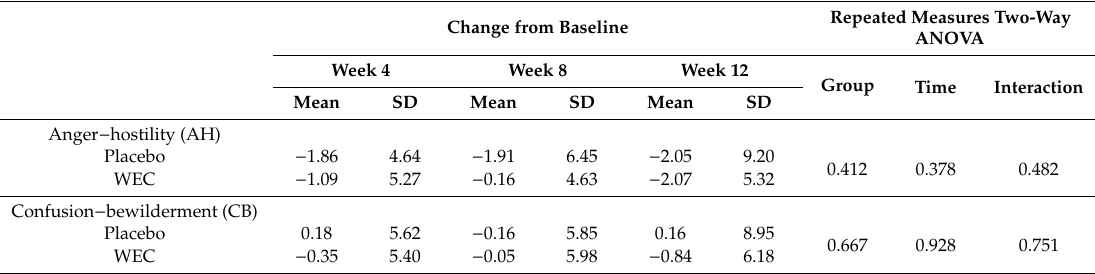
Table 7. E ff ect of a hot water extract of Curcuma longa (WEC) on the Profile of Mood States (POMS) scores 1